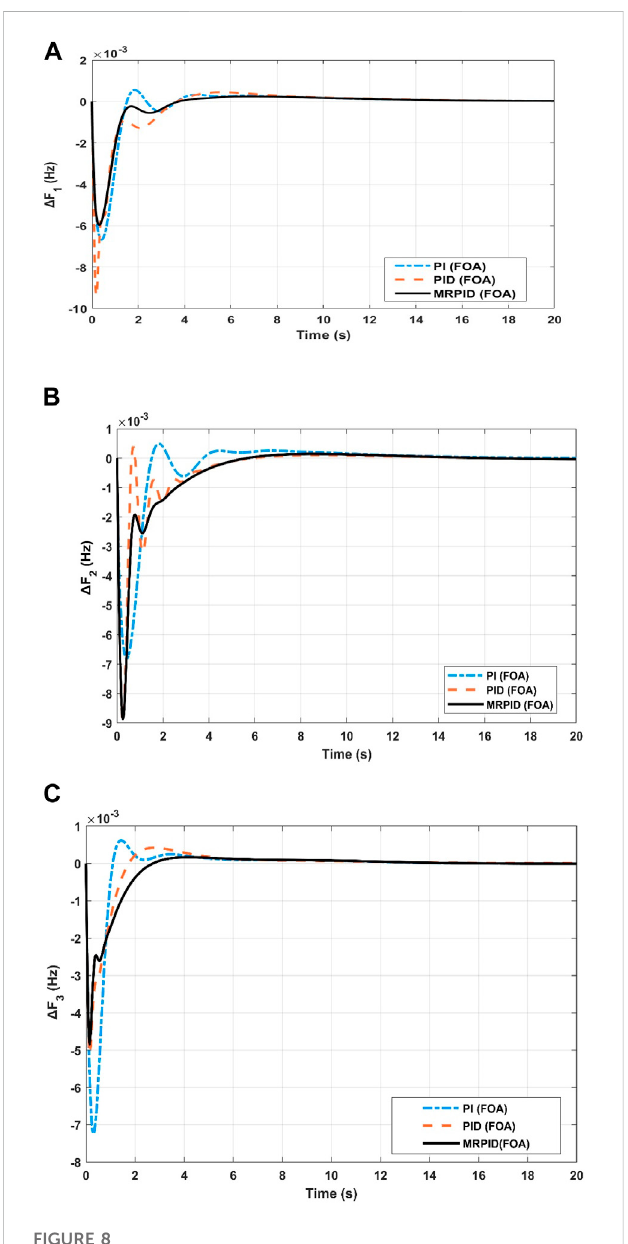
FIGURE 8 Response of the system for (A) Area 1 (B) Area 2 (C) Area